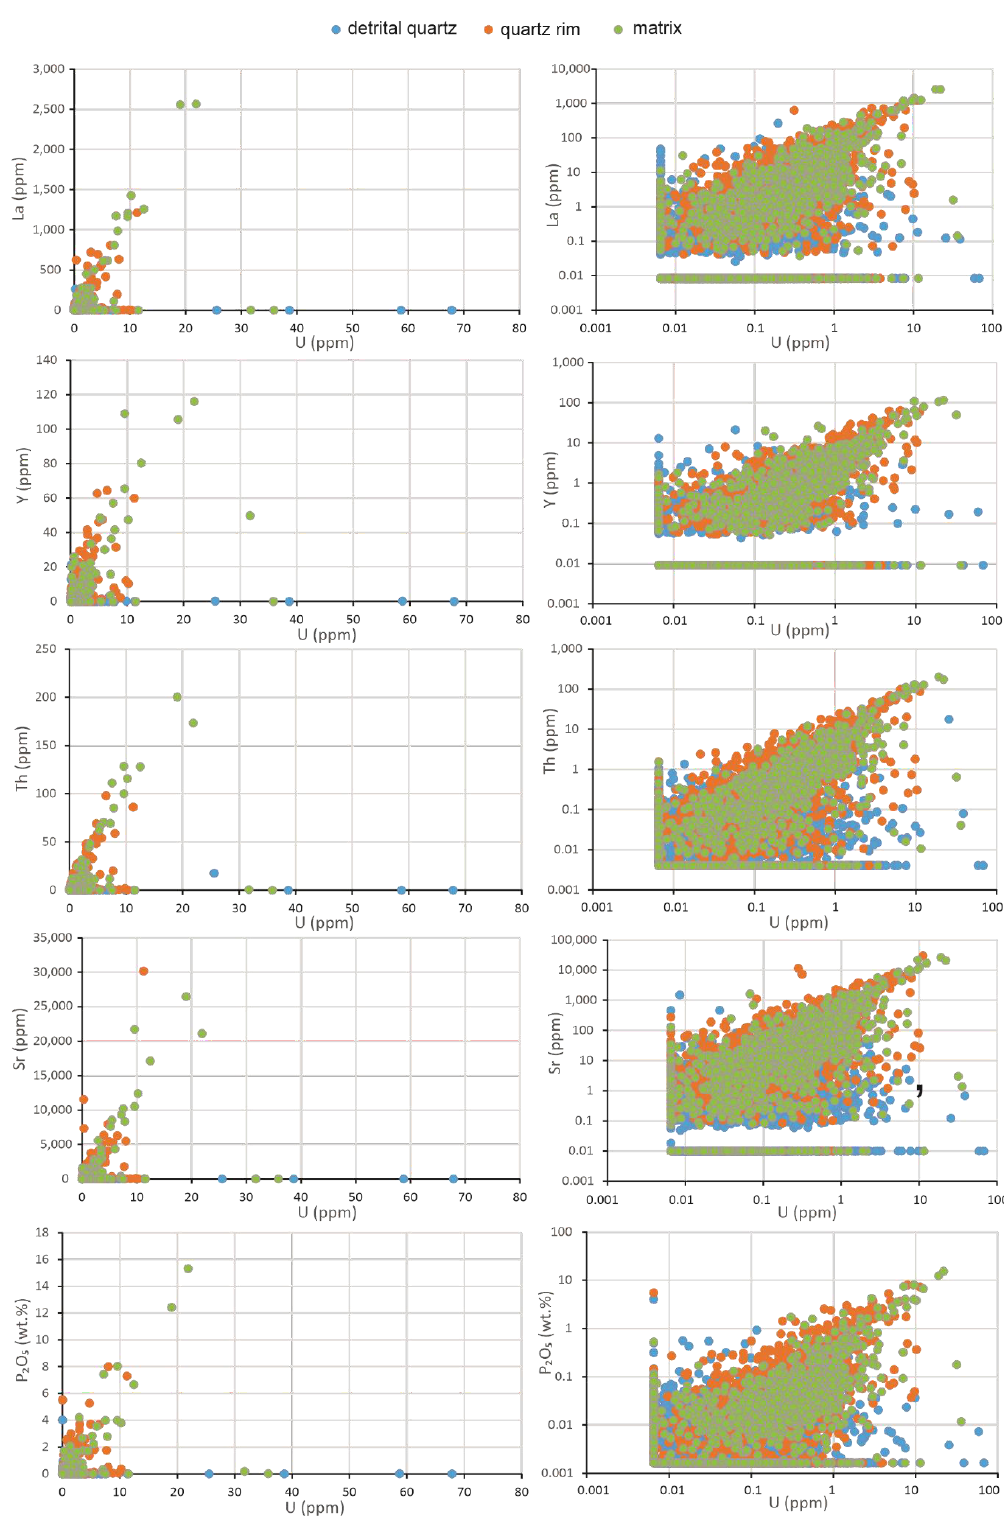
Figure 5. Bivariate diagrams showing strong positive correlations between U and La, Y, Th, Sr and P, in both linear ( left column ) and log ( right column ) scales. However, note the low concentrations of these elements for the few spots that contain the highest U (>25